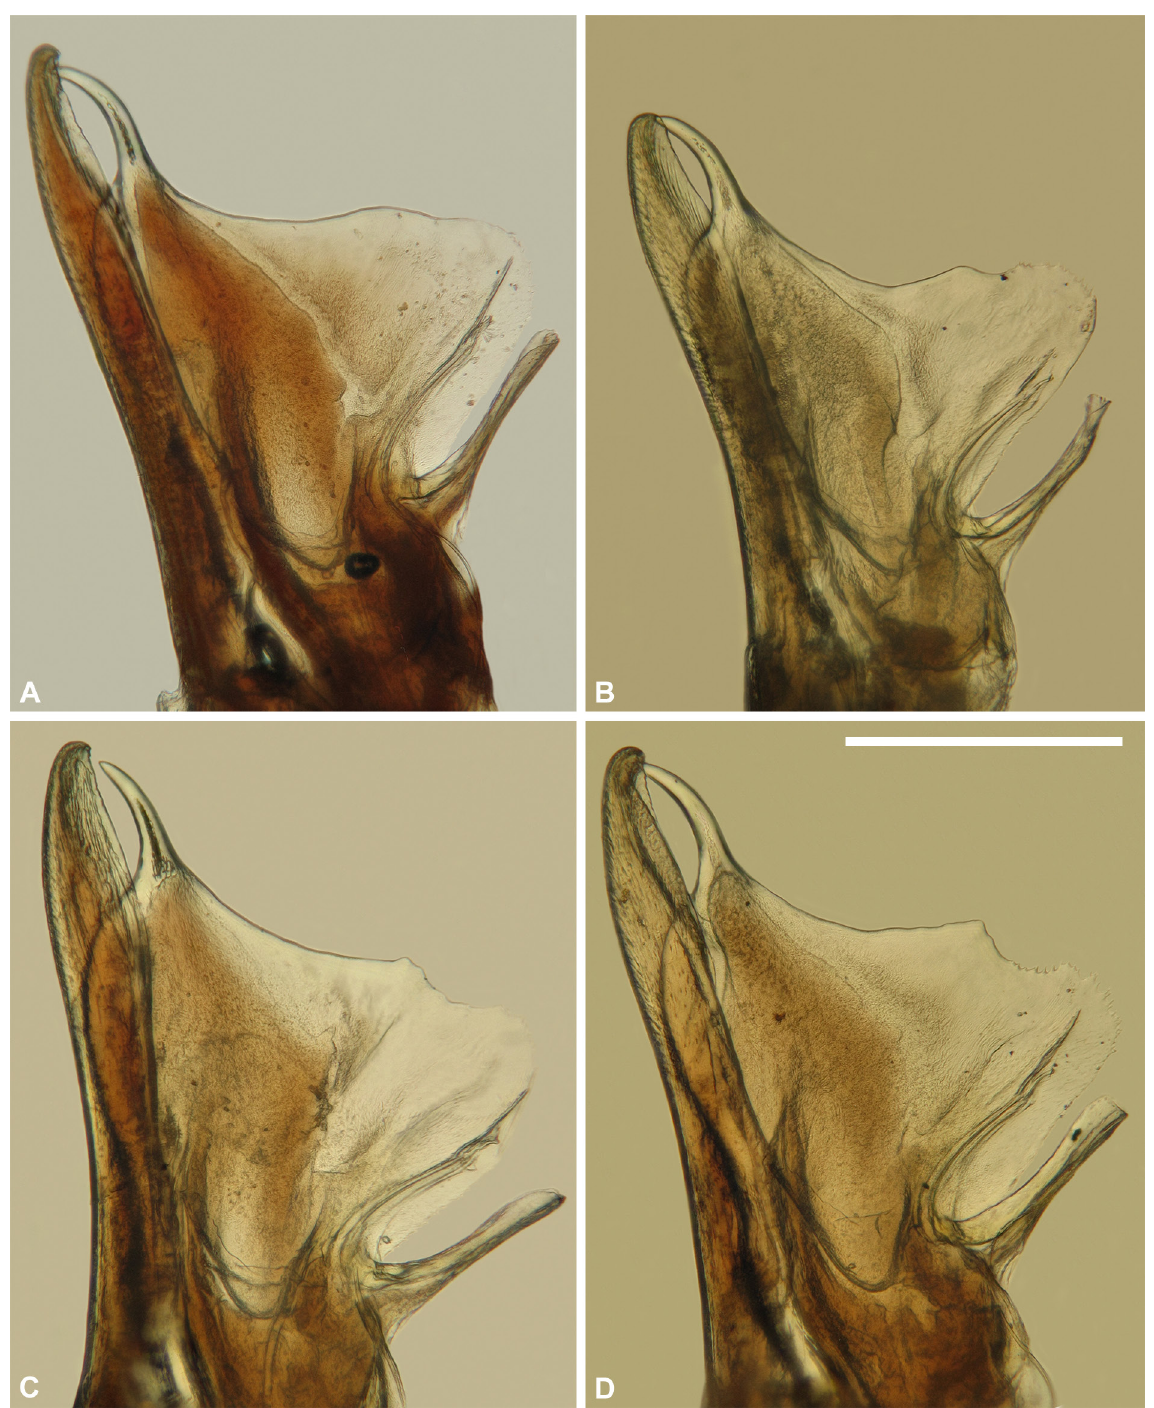
Fig. 34. Leucogeorgia prometheus sp. nov., paratype ♂♂ from Prometheus Cave (IZISU). A – D . Left gonopods, mesal views. Scale bar: 0.3